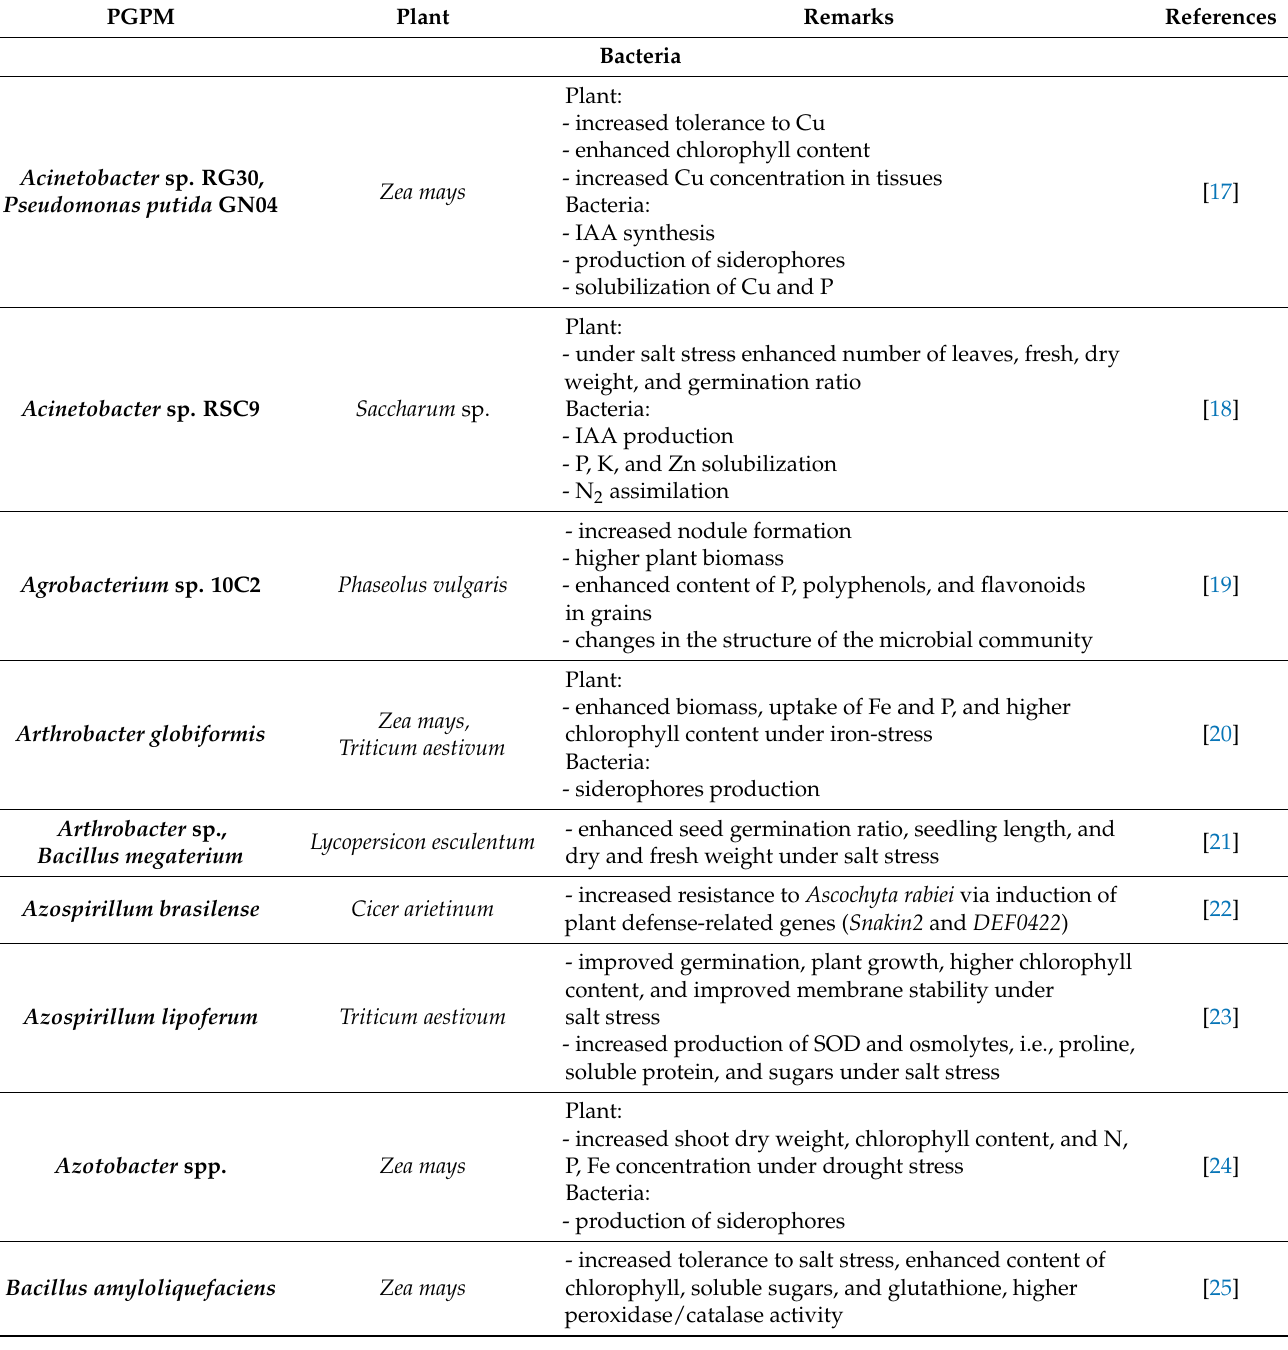
Table 1. Examples of plant growth-promoting microorganisms. The effect of PGPM on plants and, if known, the mode of action of microorganisms is also